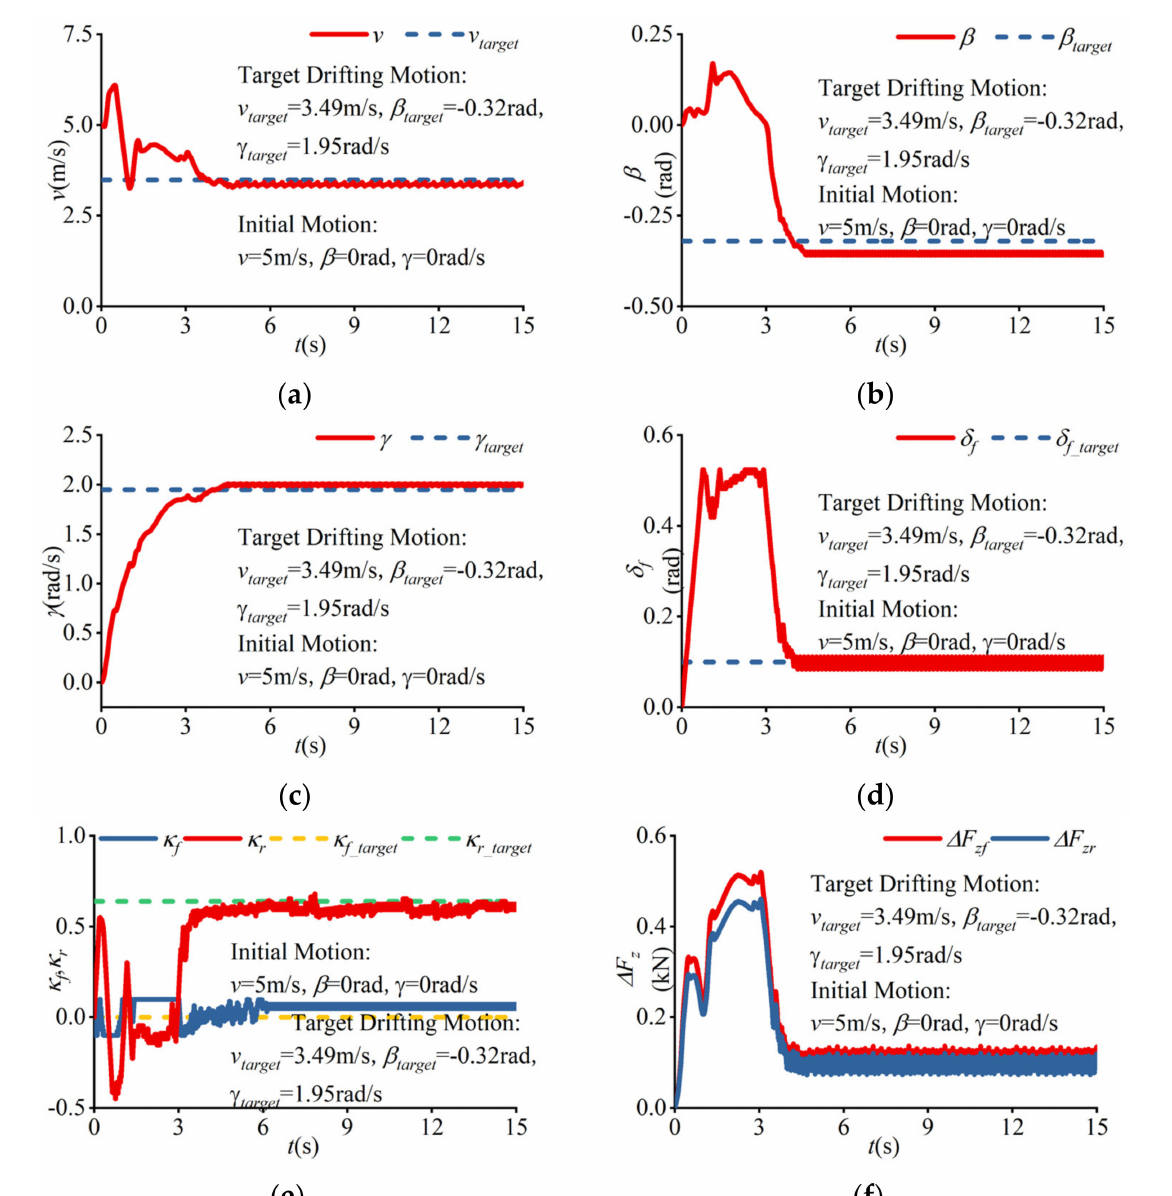
Figure 7. The simulation result with the initial motion as Group 1 in Table 3 to realize the target drifting motion as Group 1 in Table 2: ( a ) the variation curve of the velocity; ( b ) the variation cure of the sideslip angle; ( c ) the variation curve of the yaw rate; ( d ) the variation cure of the steering angle; ( e ) the variation curves of the TYDEX longitudinal slip ratios; ( f ) the differences between the steady-state vertical load transforms of the active rolling and the normal rolling based on Equations (4)–(9), where ∆ F zf =